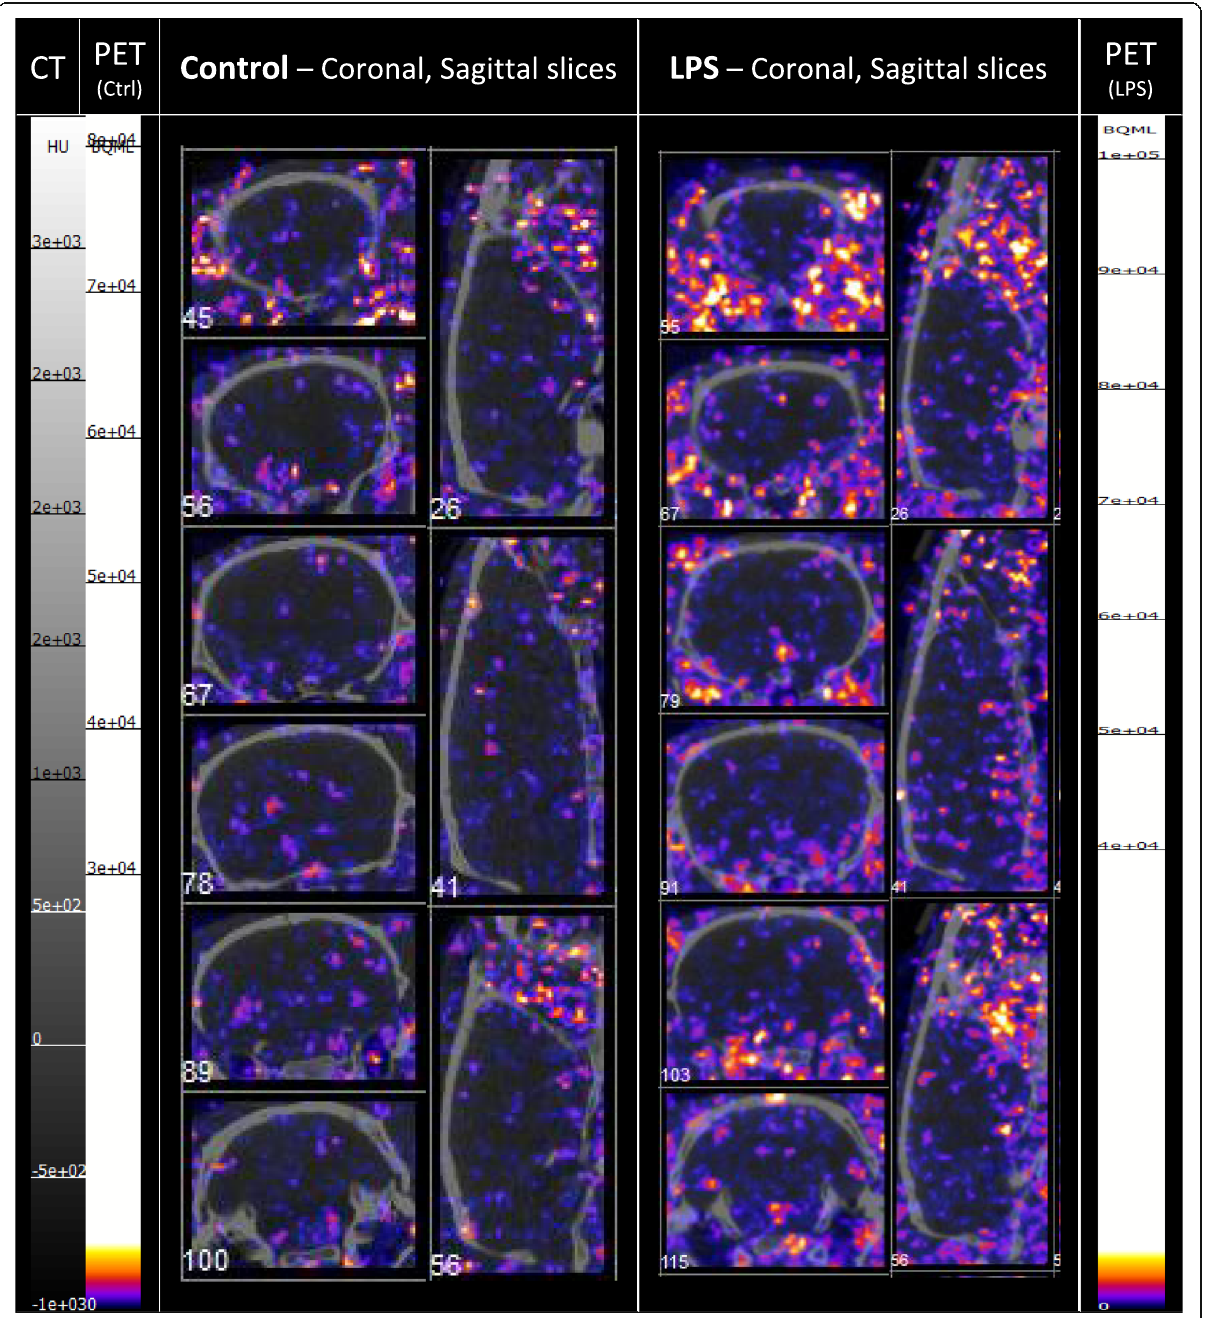
Fig. 7 Selected coronal and sagittal tile views of PET/CT scans at 22.5 min in control (ctrl) and LPS male Sprague – Dawley rats injected with comparable doses of [ 18 F]EFB. Tile numbers nominally indicate the distance of the slice from the front (coronal) and left side (sagittal) of the brain, but do not necessarily correspond between different animals. The grey scale in Hounsfield units (HU) refers to the CT data, while the colour scales in Bq/mL refer to the control rat ( left ) and LPS rat ( right ) PET